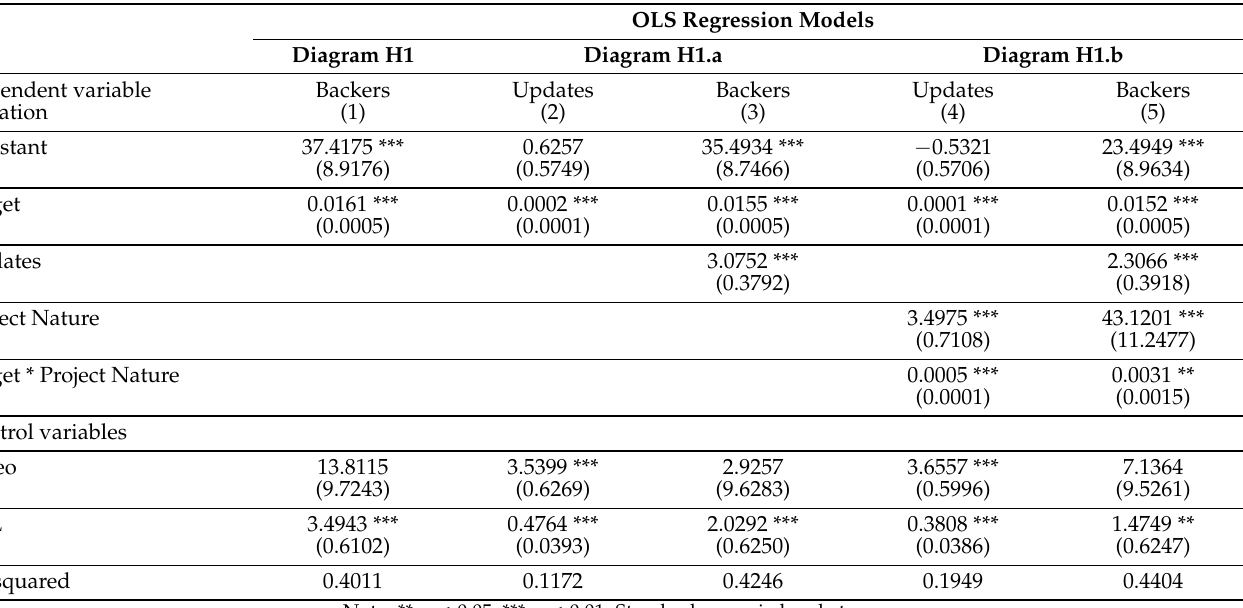
Table 3. Results of the effects of Target , Updates and Project Nature on Backers . OLS Regression Models Diagram H1 Diagram H1.a Diagram